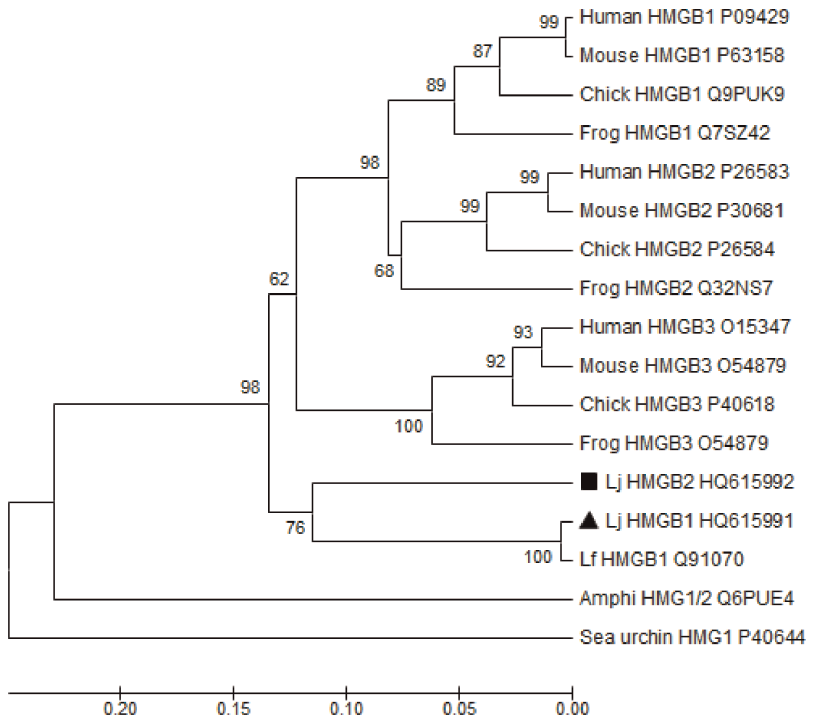
Figure 3. Phylogenetic relationship of lamprey HMGB1 with other HMGB members. A phylogenetic tree was constructed based on the amino acid sequences of HMGB from Fig. 2. The number at each node indicates the percentage of bootstrapping after 1000 replications. The bar (0.05) indicates genetic distance.